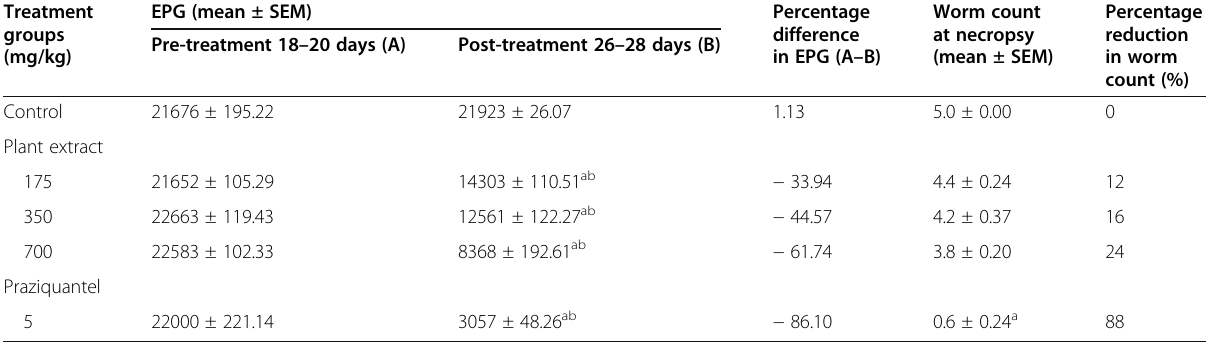
Table 1 In vivo anthelmintic effect of C. compressus methanolic root extract* on adult stages of H. diminuta infection in rats Treatment